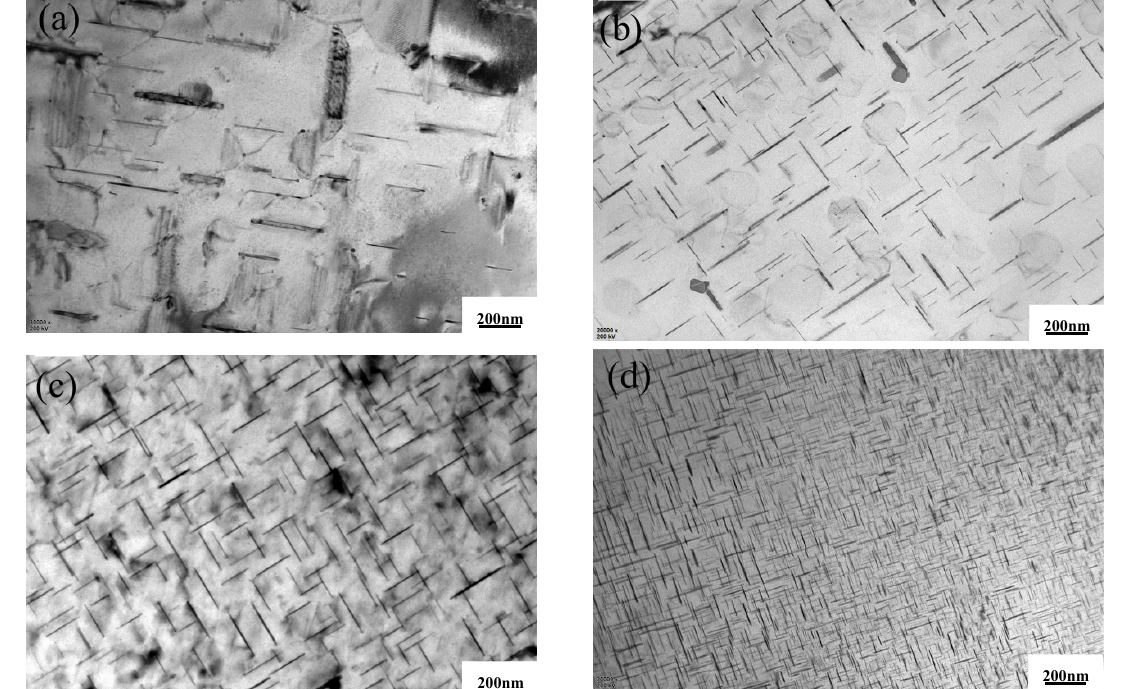
Figure 14. TEM bright-field images of ( a ) ZL205A alloy, ( b ) ZL205A + 0.1%La alloy, ( c ) ZL205A + 0.3%Al–5Ti–0.8C alloy, and ( d ) ZL205A + 0.1%La + 0.3%Al–5Ti–0.8C alloy after T5 treatment.